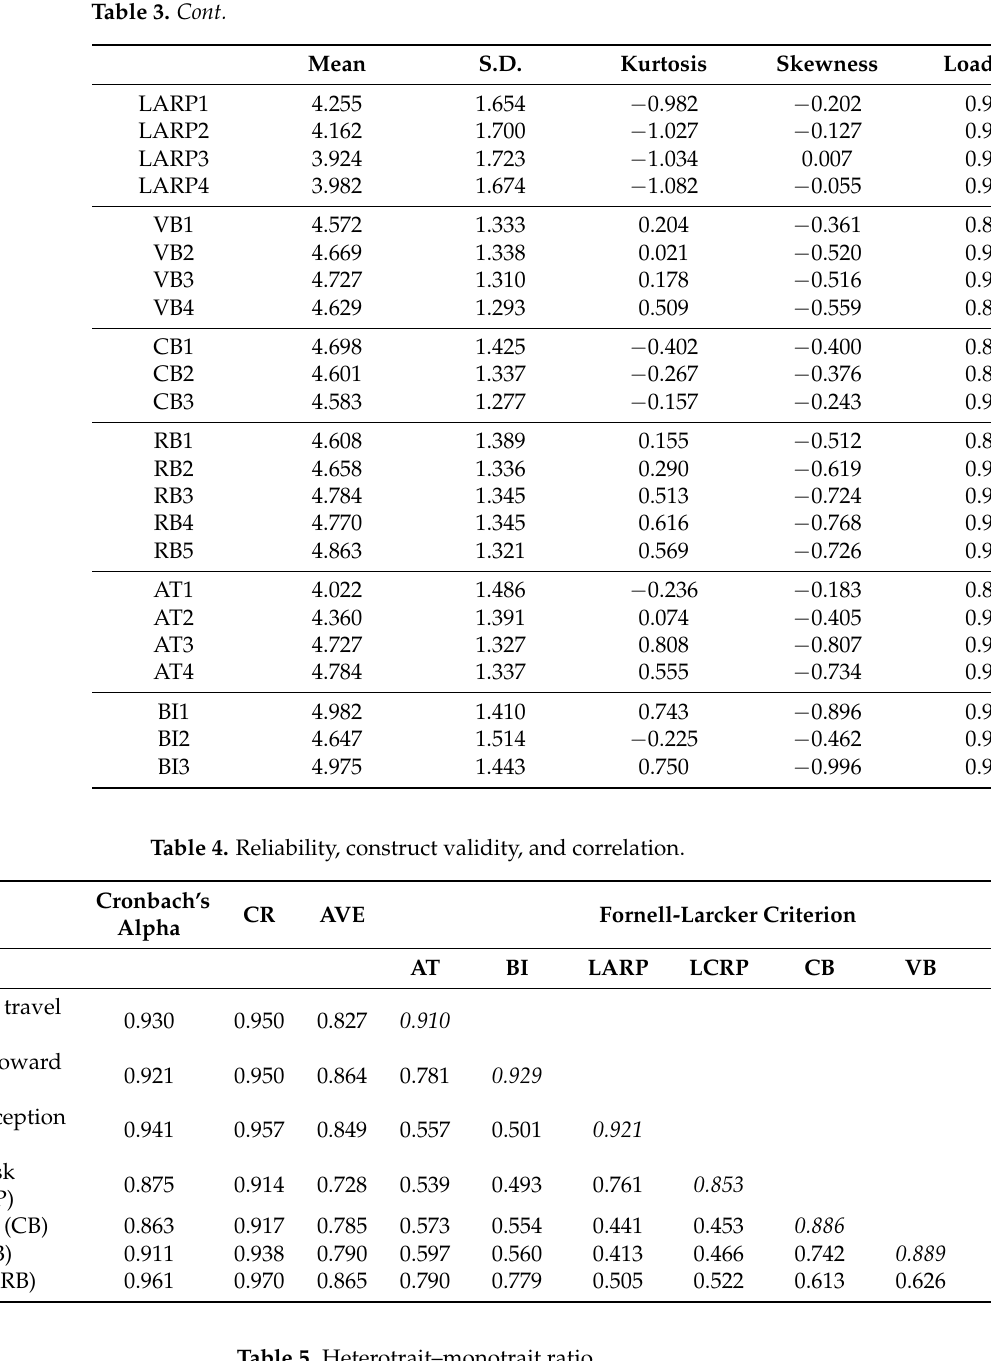
Table 5. Heterotrait–monotrait